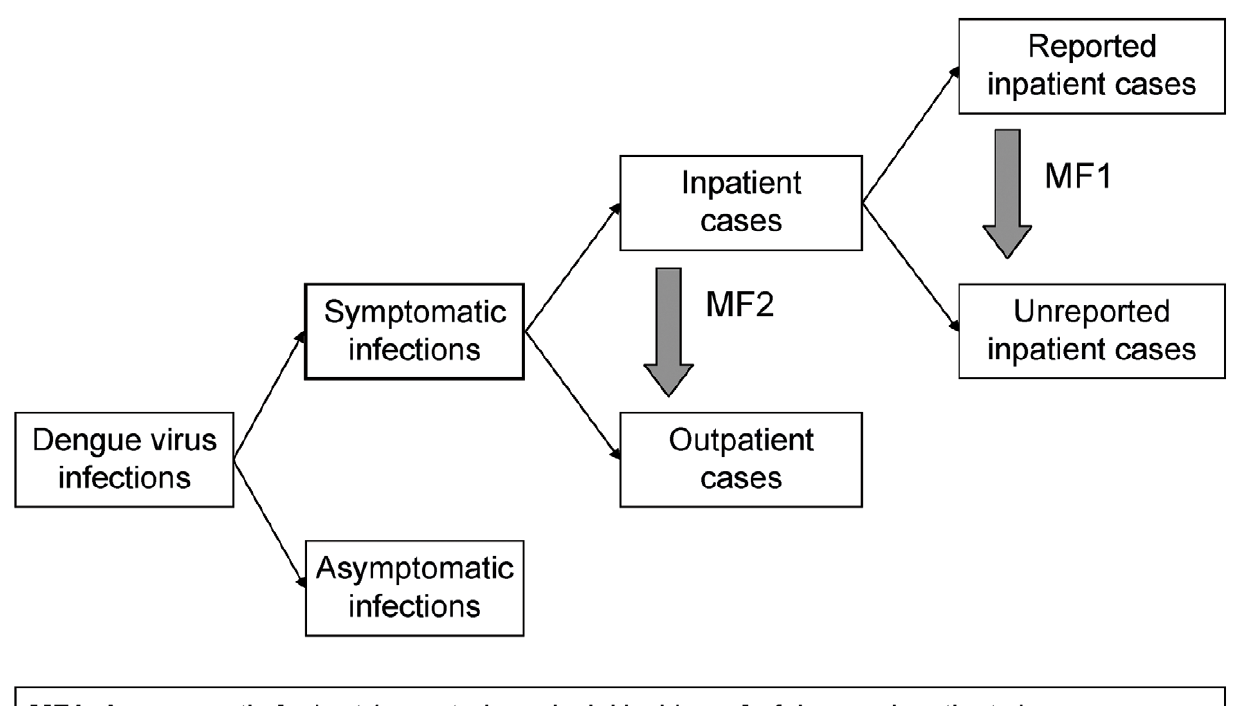
Figure 2. Methodology used to establish better disease burden estimates of symptomatic dengue virus infections. The estimates are based on numbers of nationally reported inpatient dengue cases and average multiplication factors (MF), which were generated by comparing provincial reporting data with data from prospective cohort studies in the same province.